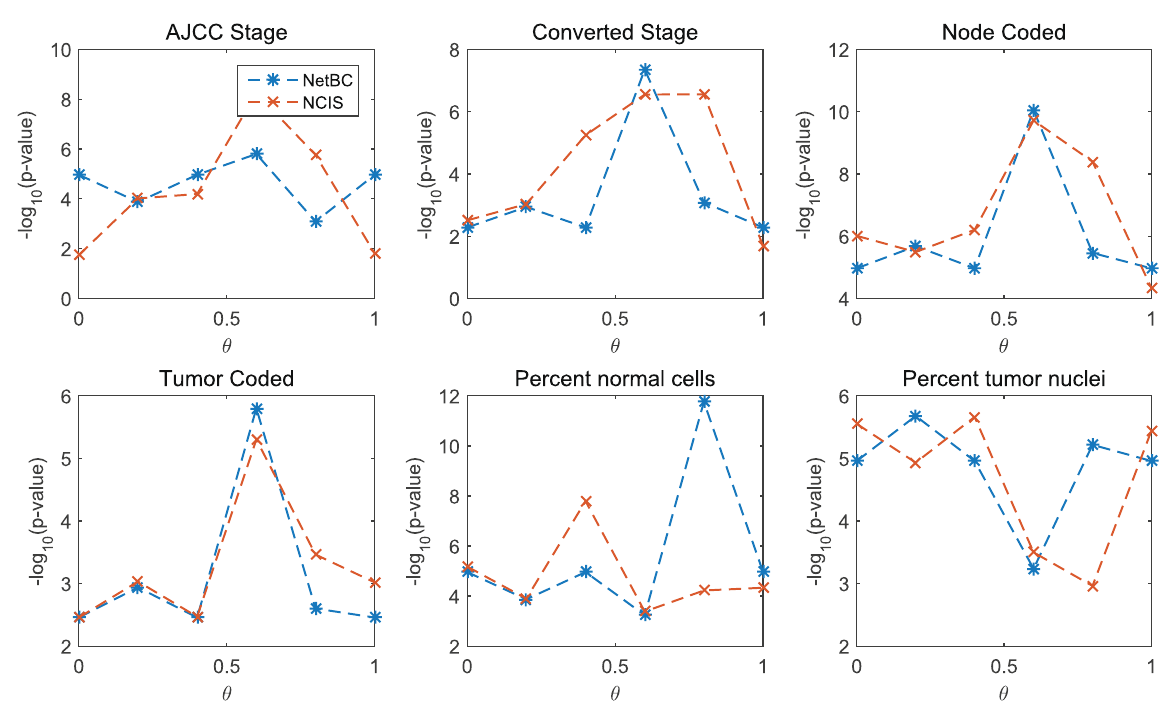
Figure 2. p -value of the dependence test between different clinical features and sub-types of Breast cancer discovered by NetBC (or NCIS) under different input values of θ For all the clinical features, we use the Chi- squared test. The p value is adjusted by Benjamini & Hochberg method. Larger − log 10 ( p -value) means better